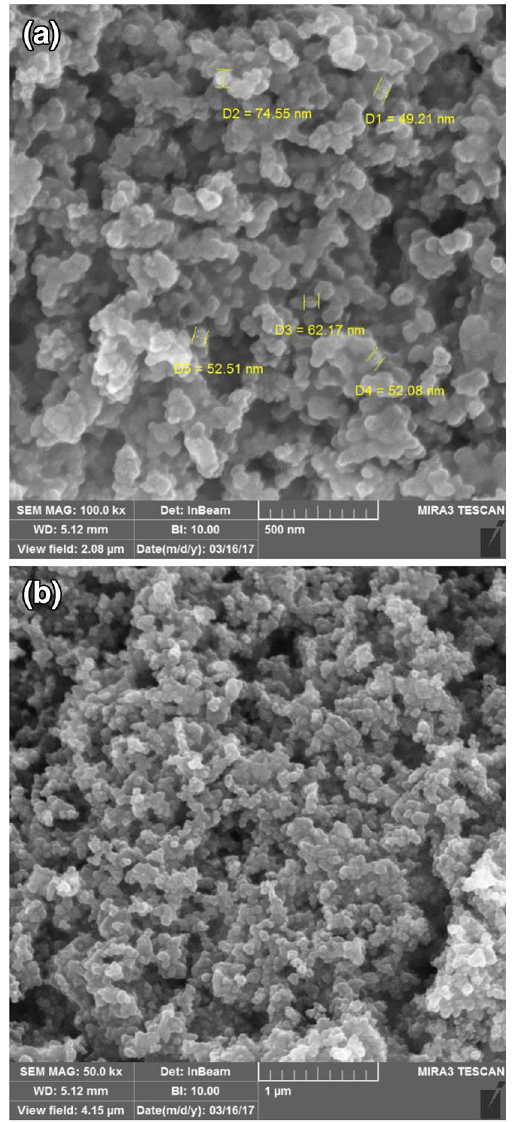
Fig. 4 SEM images of GNPs film surface in scales a 500 nm, b 1 μm